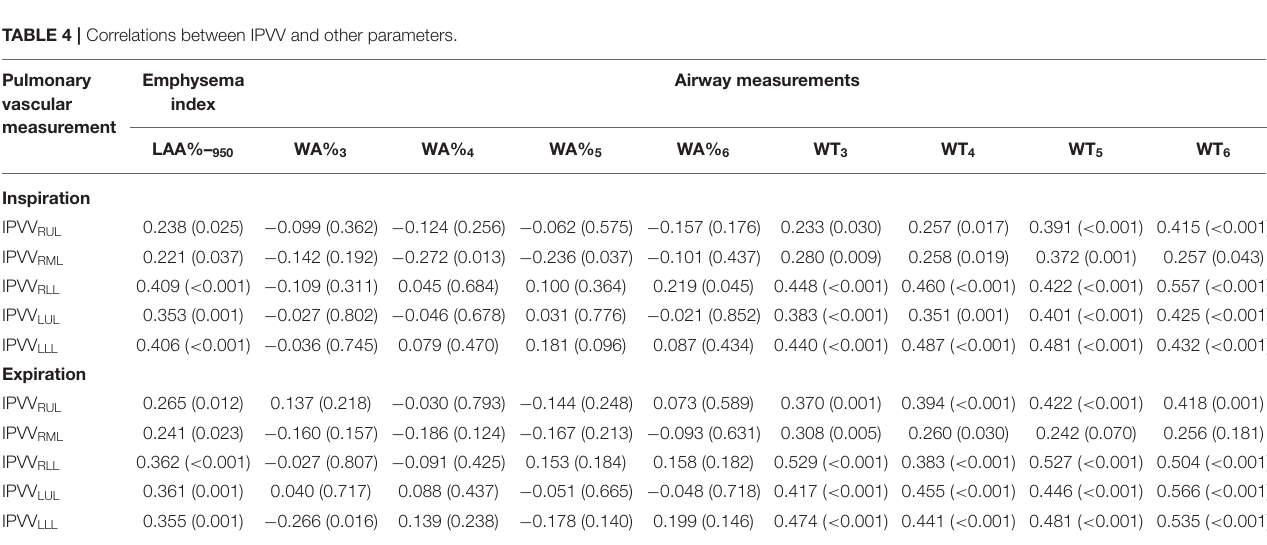
FIGURE 7 | Correlations of IPVV in individual lobes with WT 5 in the expiratory CT scan. (A) RUL; (B) RML; (C) RLL; (D) LUL; (E) LLL.